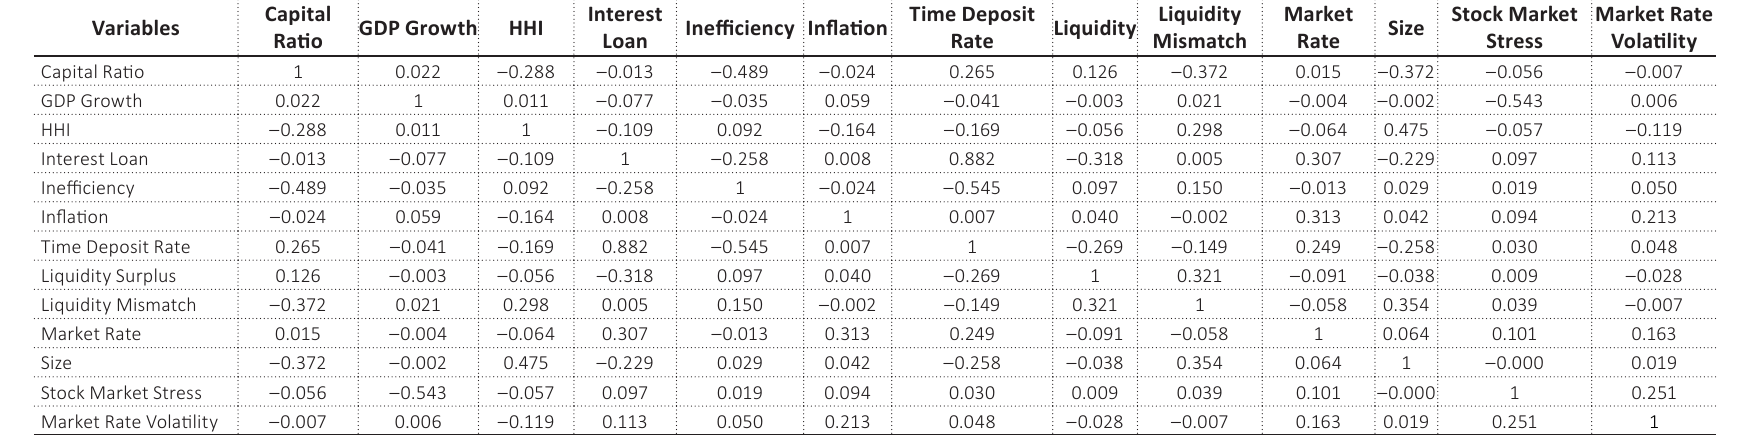
Table C2. Correlation within variables equation 3 (Time Deposit Rate – the